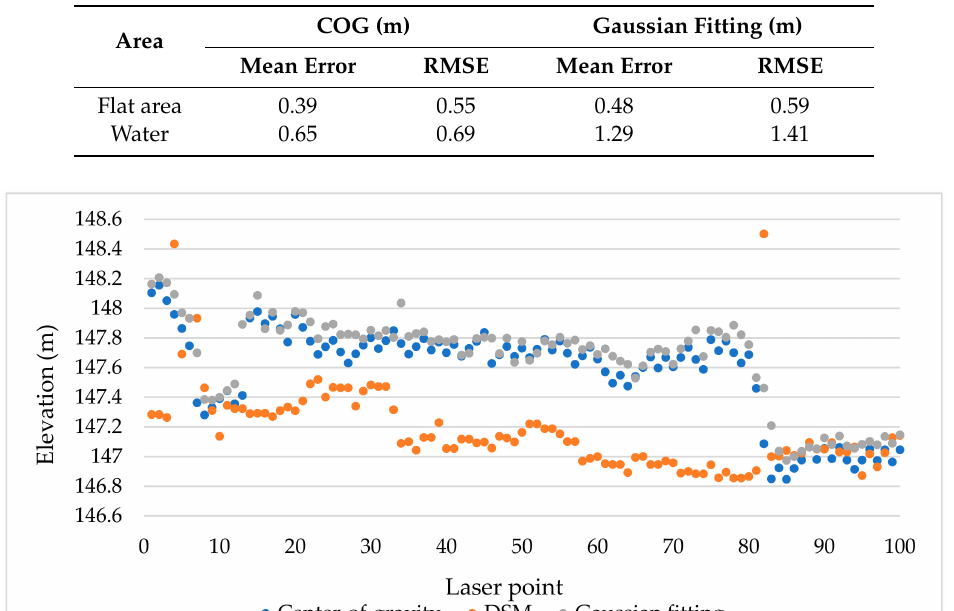
Table 2. Validation results of the elevation accuracy of the two methods.